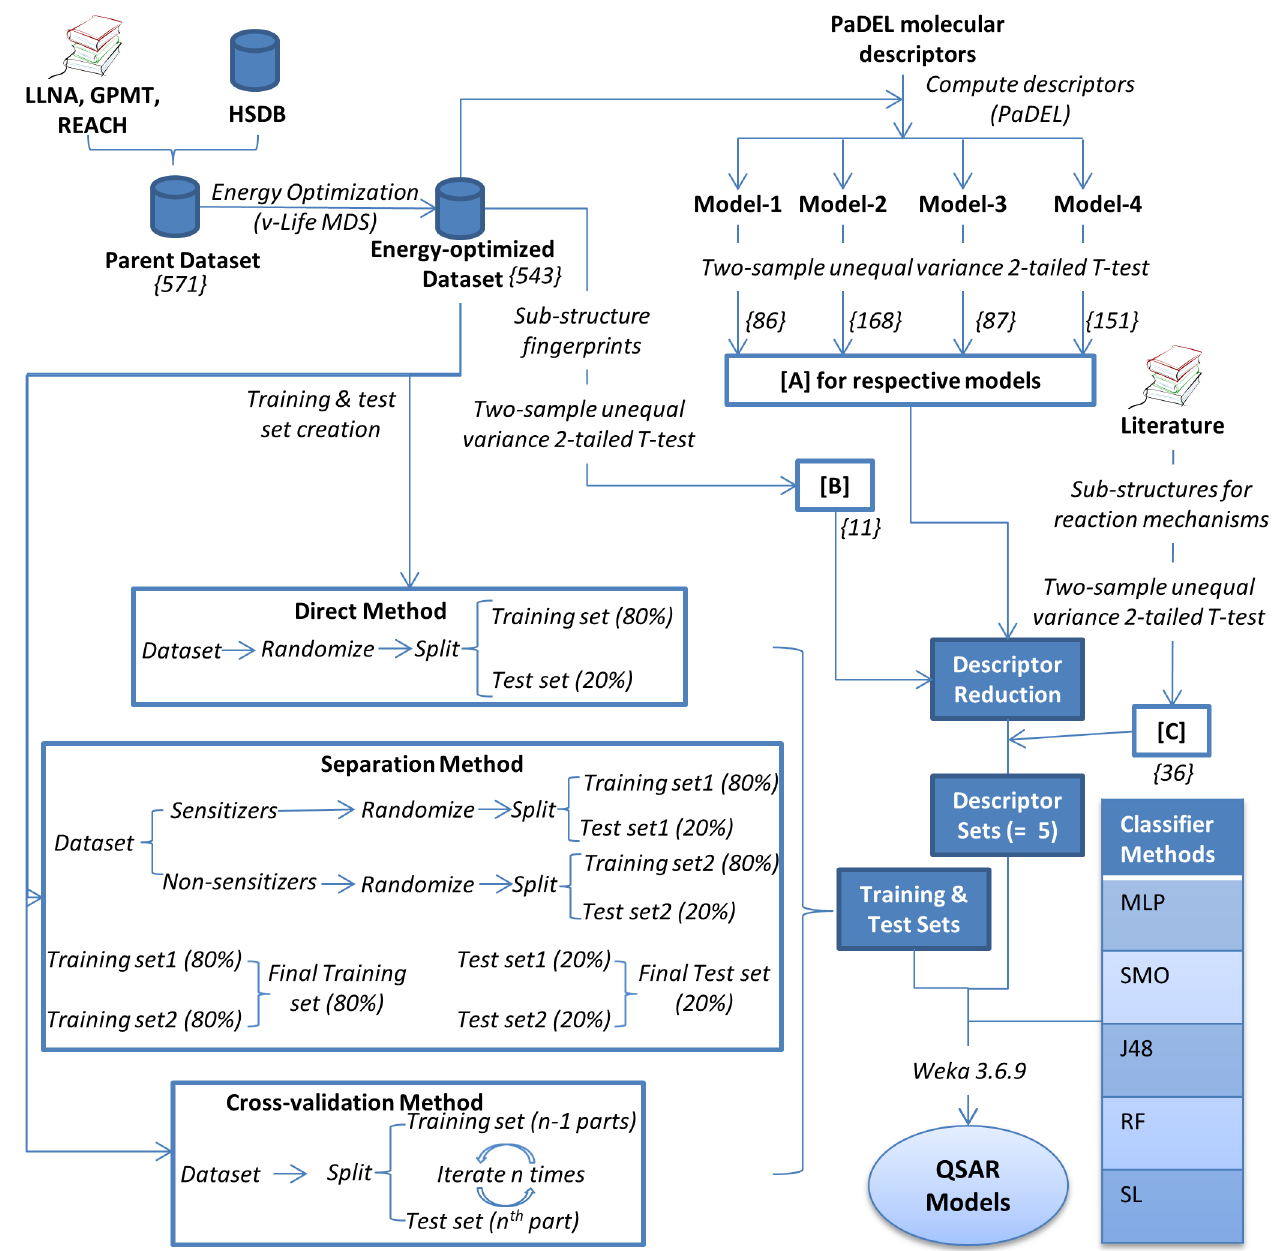
Fig 1. Steps followed for building QSAR models. QSAR: Quantitative Structure-Activity Relationship; GPMT: Guinea Pig Maximization Test; HSDB: Hazardous Substance DataBase; LLNA: Local Lymph Node Assay; REACH: Registration, Evaluation and Authorization of Chemicals; MLP: Multi-Layer Perceptron; RF: Random Forest; SL: Simple Logistic; SMO: Sequential Minimal Optimization; Numbers in curly brackets represent the count of respective entities (i.e. molecules, descriptors and fingerprints).